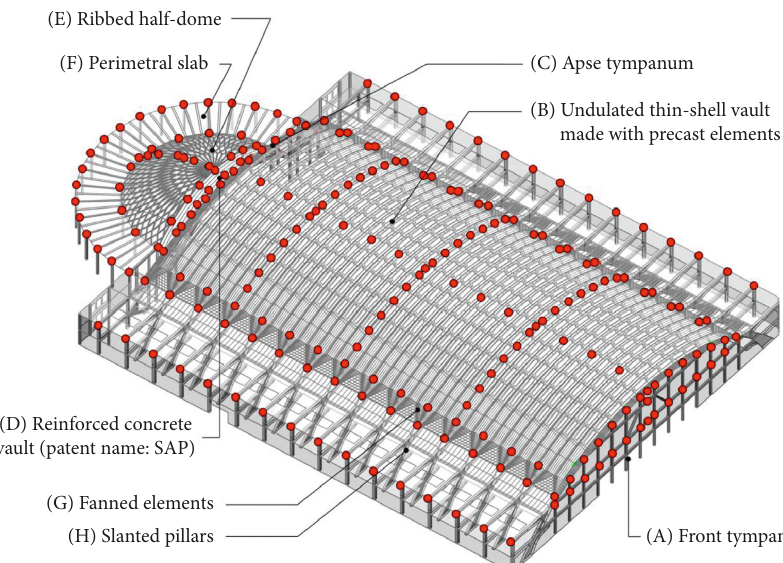
Figure 16: A 3D view of Hall B showing its macroelements and the possible sensor positions.